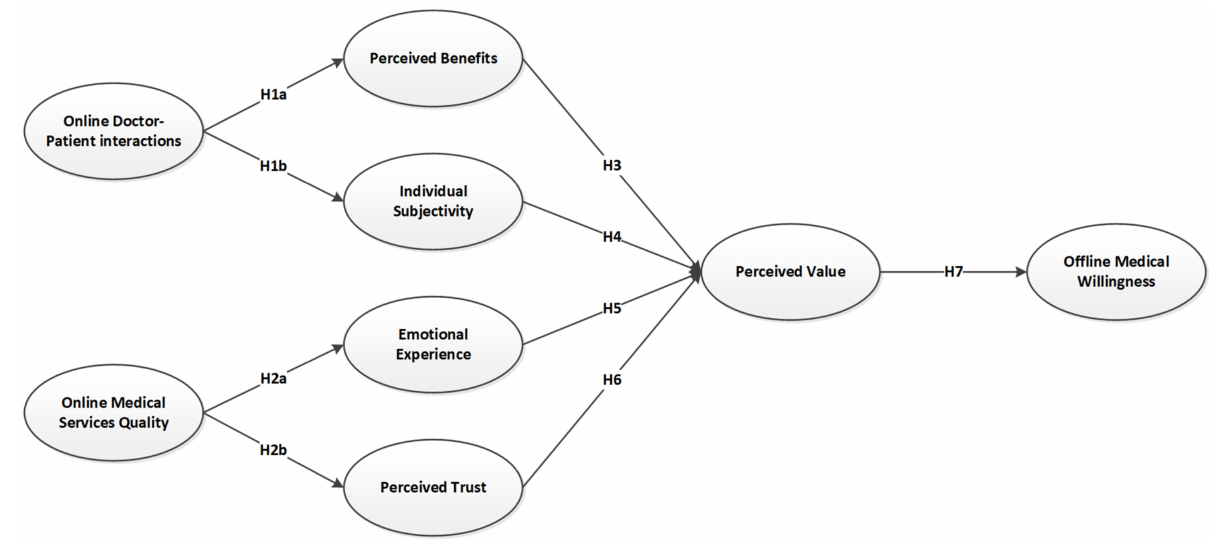
Figure 1. Research